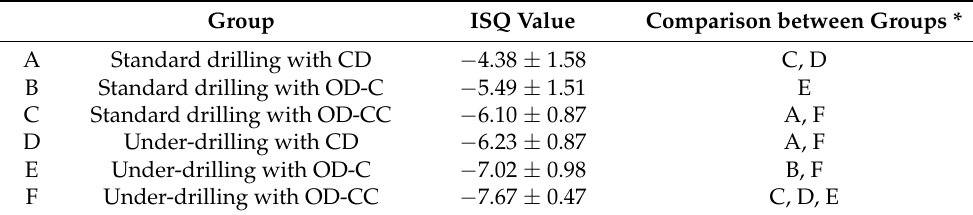
Table 2. Periotest values in the experimental groups.